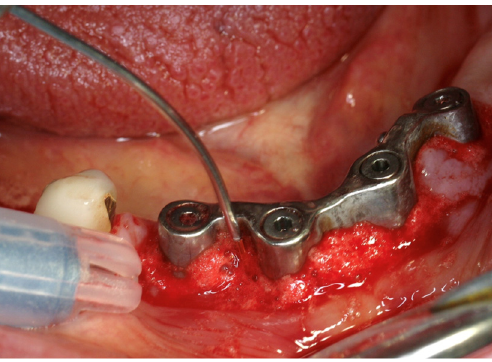
Figure 4. OHLLT non-surgical approach. Laser irradiation combined with hydrogen peroxide 10 vol. 3%.